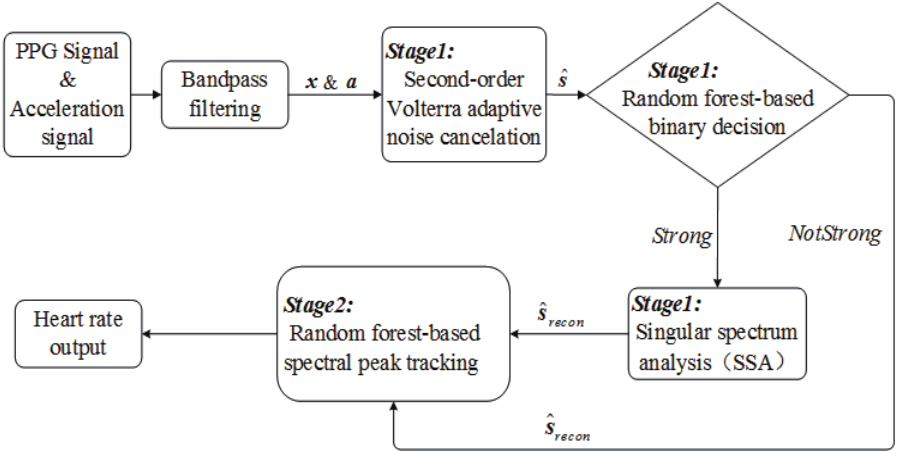
Figure 1. The flowchart of our proposed HR estimation approach.